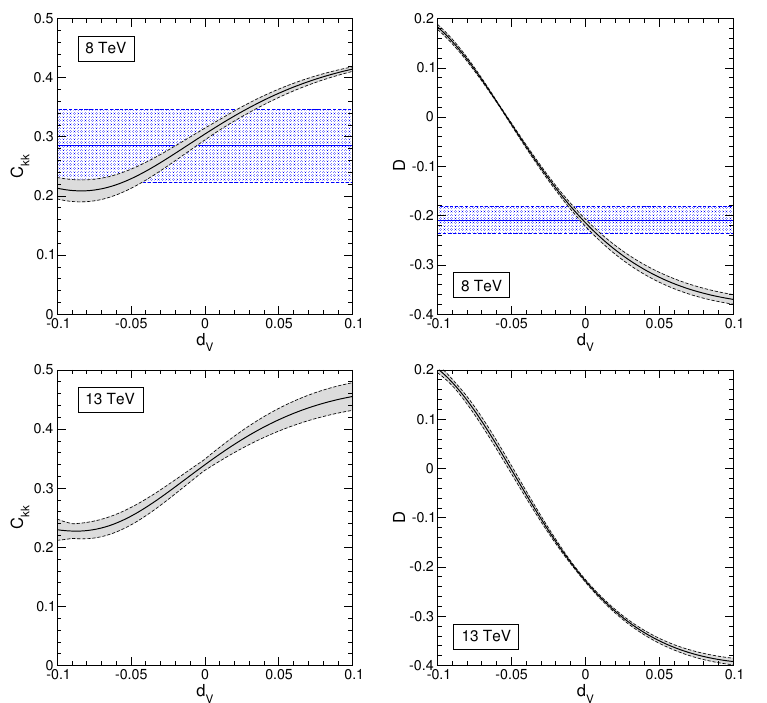
Figure 7 . Dependence of the spin correlation coe(cid:14)cients C kk and D on a possible top chromo- magnetic moment d V , for CM energies of 8 TeV and 13 TeV. The horizontal bands represent the naive averages of ATLAS and CMS measurements and their 1 (cid:27)